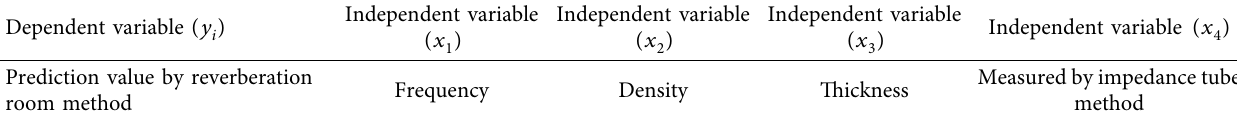
Table 1: Multiple regression analysis variables.